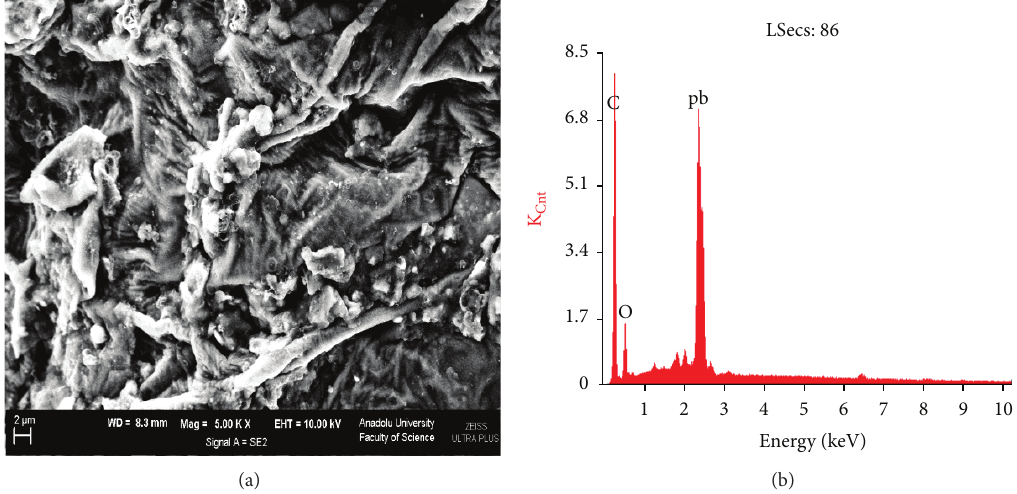
Figure 3: SEM image and EDS spectrum of SAC2 after lead (II) adsorption.